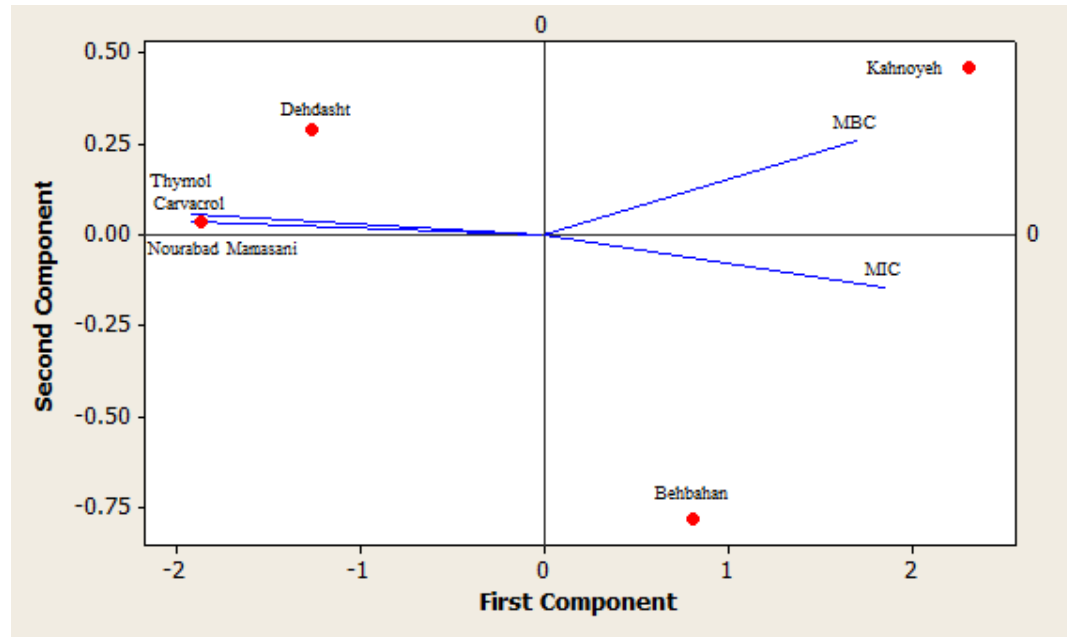
Figure 1. Biplot of the first two principal components (PCs) for the thymol and carvacrol contents and the MIC and MBC values of Oliveria decumbens populations.